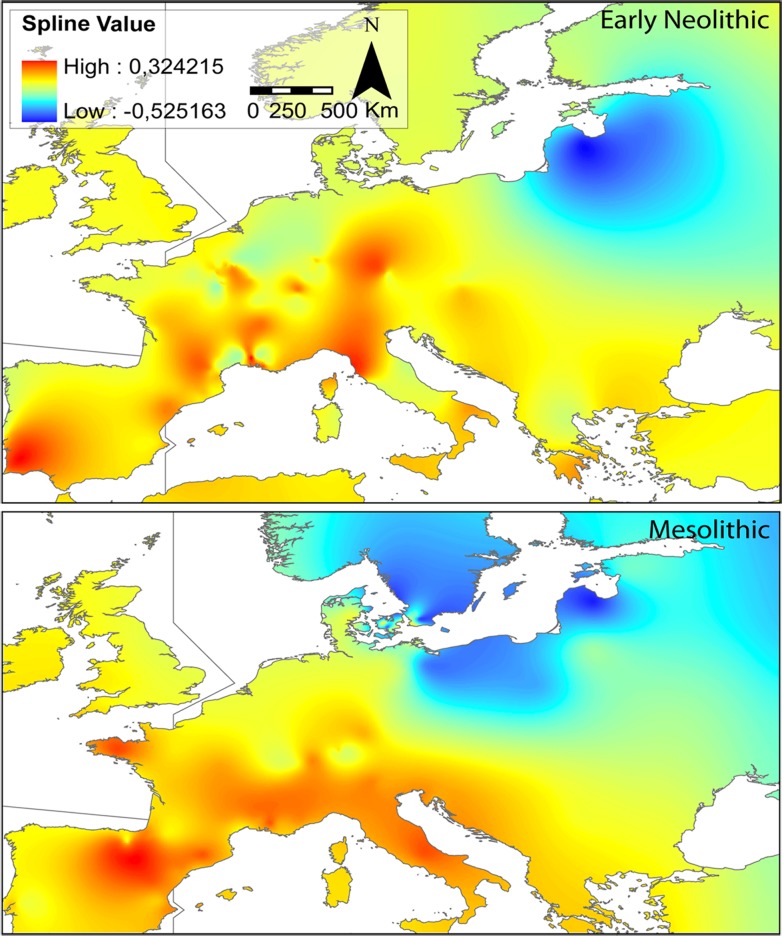
Spline interpolation of the first axis of the Principal Coordinates Analysis.Geographic structure differentiation between Mesolithic and Early Neolithic indicates reshaping of the bead-type diversity in Europe during the transition to farming. Maps were made by S.R. by using ArcGIS 9.3.1 software.